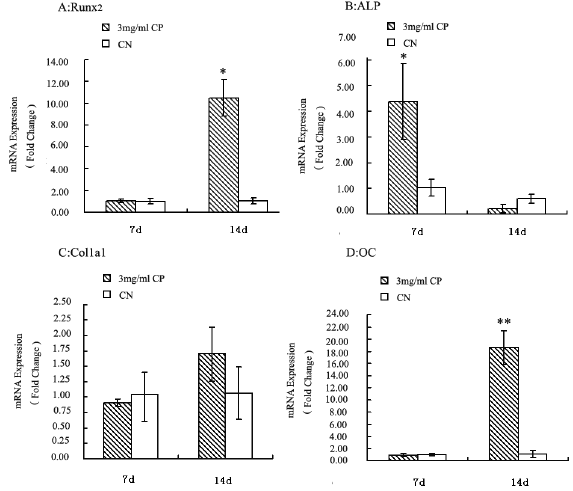
Figure 3. Real-time-PCR analysis of the expressions levels of different osteoblast markers after bovine CP compound treatment. Real-time PCR analyses of the Runx2 (A), ALP (B), Col1 a 1 (C), and OC (D) mRNA levels in MC3T3-E1 cells induced with osteogenic medium after treatment with 3 mg/mL CP or no treatment (CN) for 7 or 14 days are shown. The results were normalized by the mRNA levels of b -actin as a housekeeping gene. Data are expressed as means 6 standard deviation ( n =4). * p , 0.05, ** p , 0.01, Significant difference from CN. CP: bovine collagen peptides compounds; CN: control.